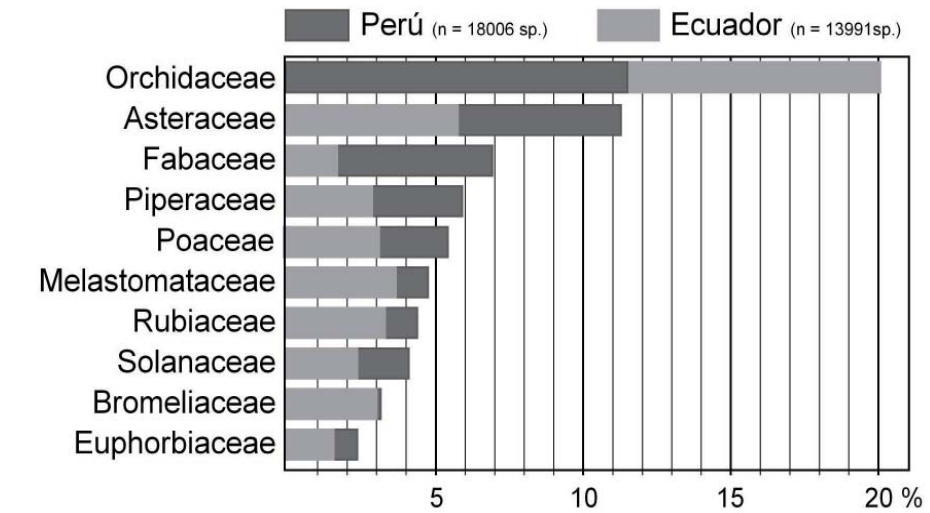
Figure 4: Percentage of the ten most important families of vascular plants in Ecuador and Peru (data base: Jørgensen and León-Yánez 1999, Brako and Zarucchi 1993). The two columns are arranged in layers one behind the other. The investigation area takes a transitory position between these two